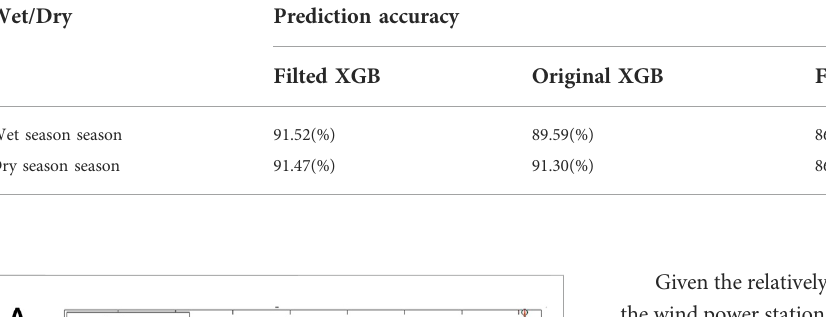
TABLE 3 Prediction accuracy of wind power.